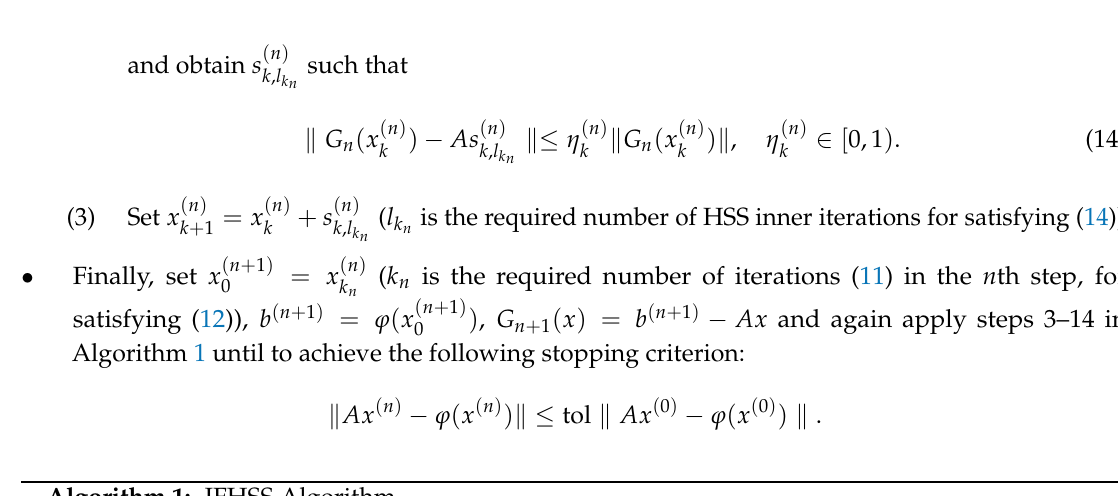
Algorithm 1: JFHSS